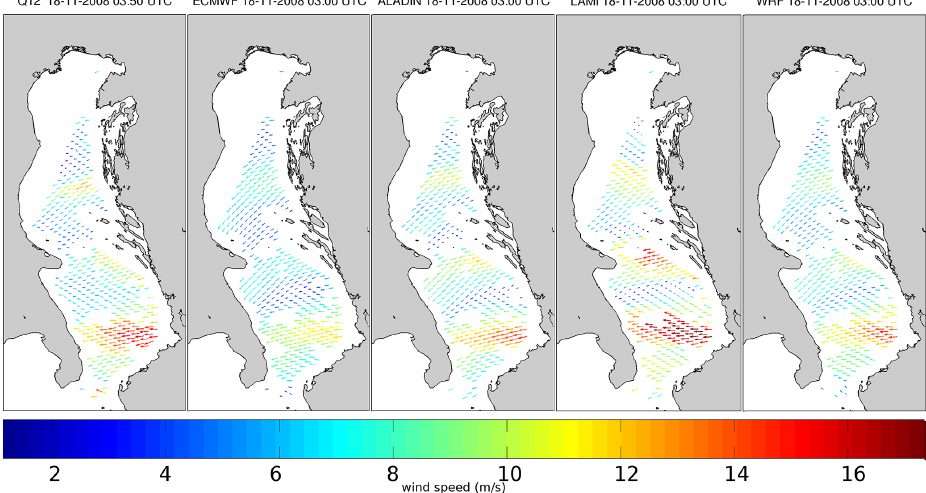
Figure 2. Sea surface wind fields on 18 November. From left to right: the scatterometer pass at 03:50 UTC, and the models wind fields (ECMWF, ALADIN, COSMO-LAMI, WRF) at 03:00 UTC. The maps are rotated 40 ◦ clockwise. The colorbar corresponds to the wind intensity, in ms − 1 , of the vector plots in the